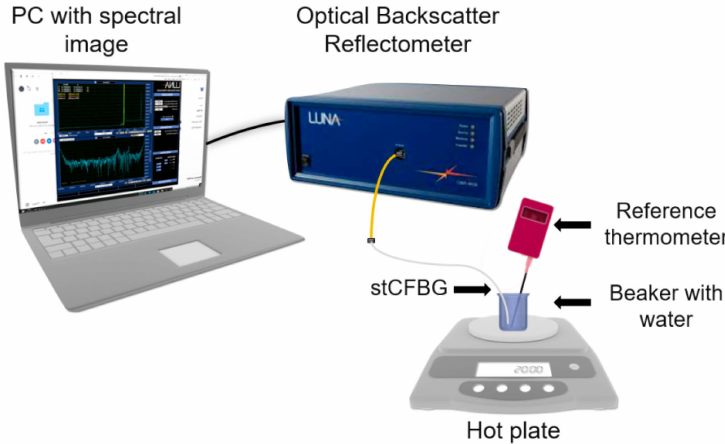
Figure 2. Schematic of the interrogation system—temperature